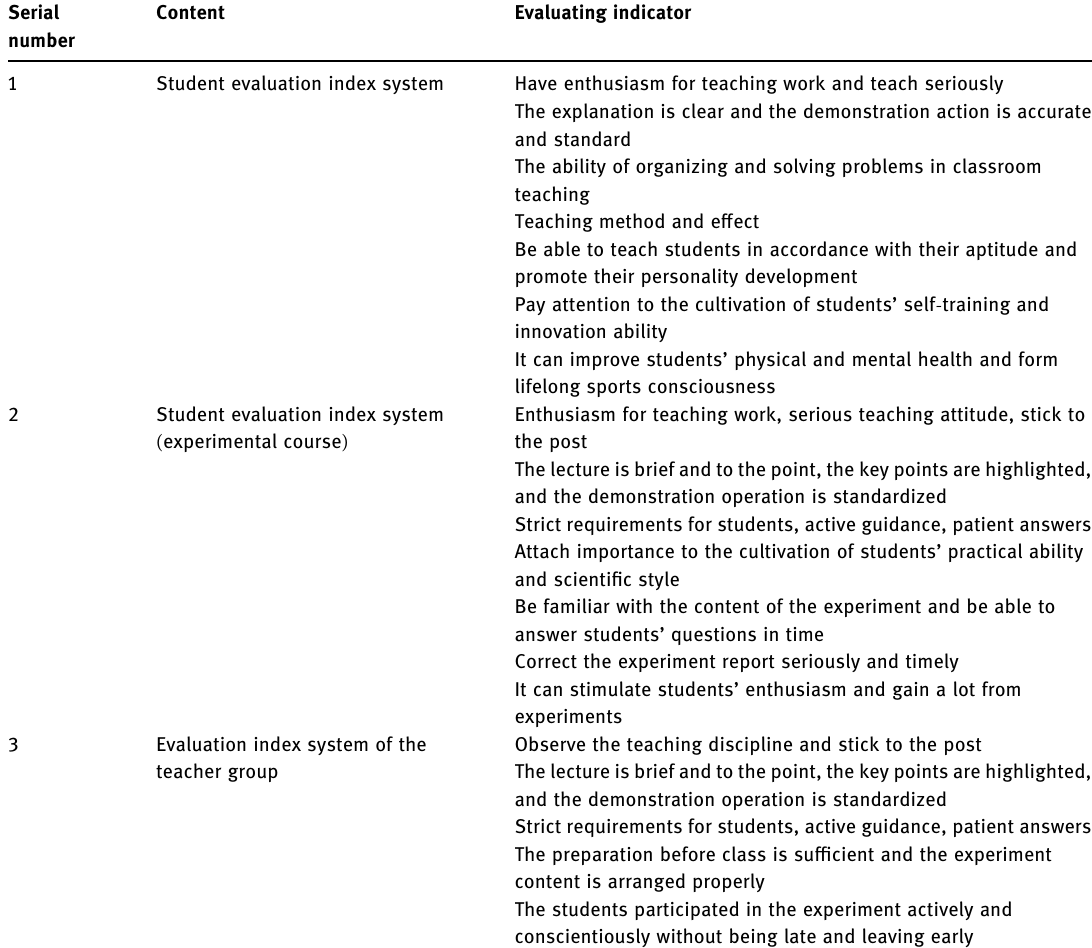
Table 2: Evaluation index of the auxiliary e ff ect of physical education teaching